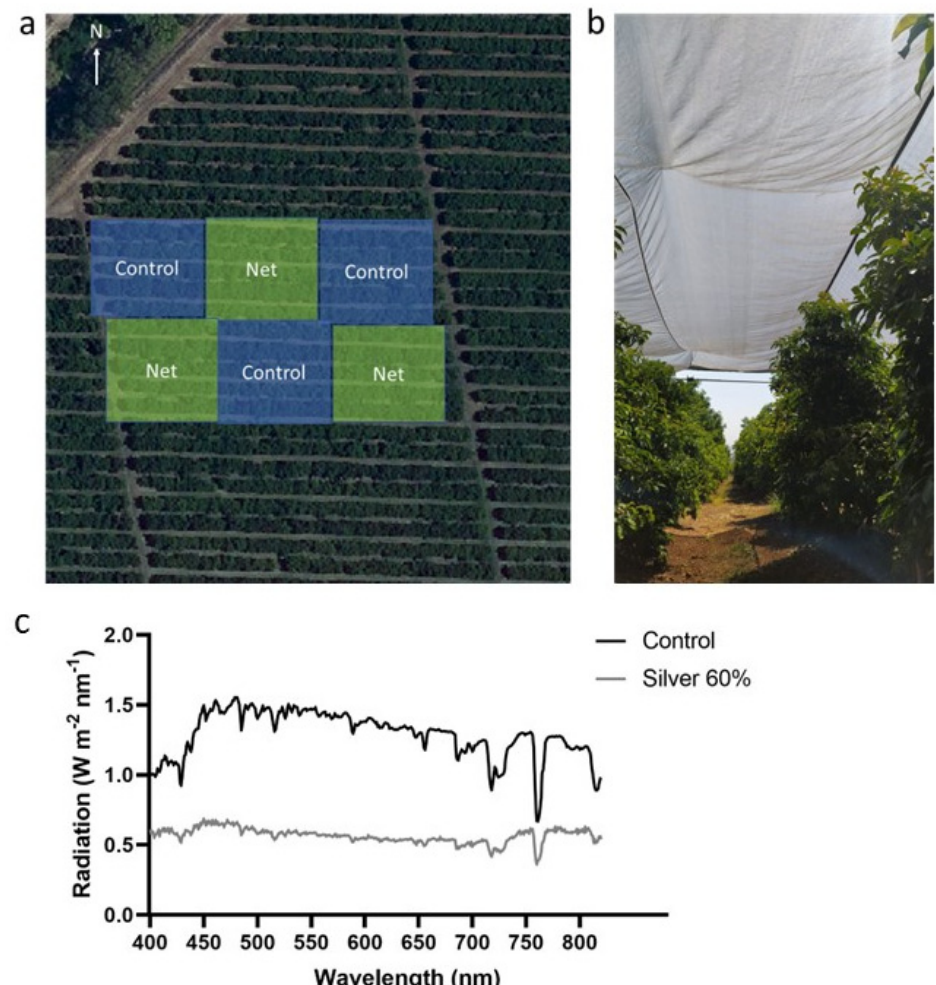
Figure 2. The experimental avocado plot and solar irradiation spectra. Experimental plots were completely randomized, with three 0.1-ha repeats for each treatment ( a ); control/net). Picture taken in August 2021, during an actual extreme heat event ( b ). Spectra of total solar irradiation under the silver 60% shading nets and control (sunlight) were measured at midday in August 2021 ( c ). Values are means of five replicates for each of the two treatments.